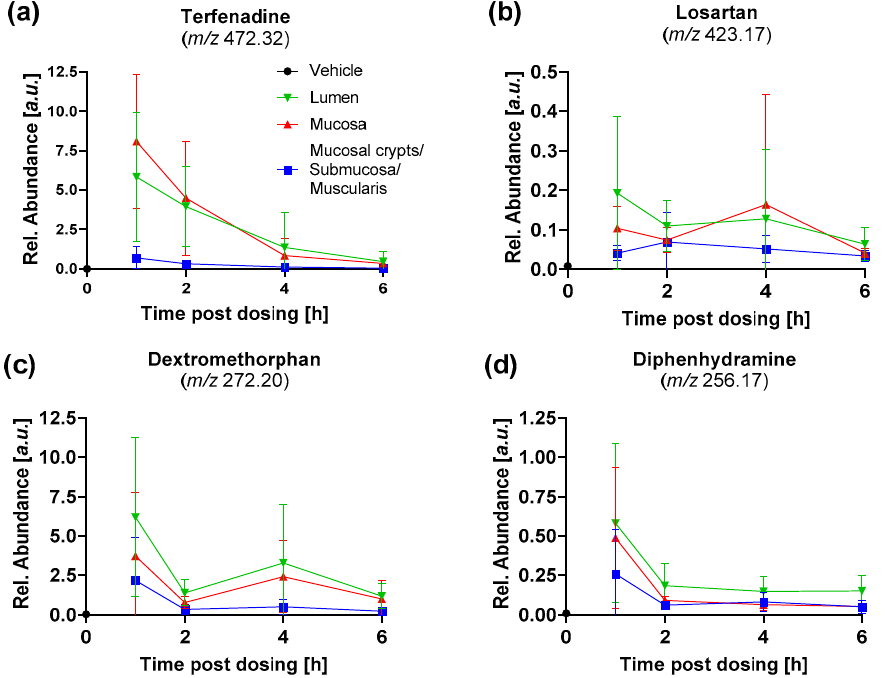
Figure 5. Abundance-time profiles of the four dosed drugs in the resolved tissue segments for ( a ) terfenadine, ( b ) losartan, ( c ) dextromethorphan and ( d ) diphenhydramine. Data is presented as mean ± SD of the nine intestinal segments analysed for each timepoint. The datapoint for the vehicle at T 0 shows the mean background noise signal for the respective drug.